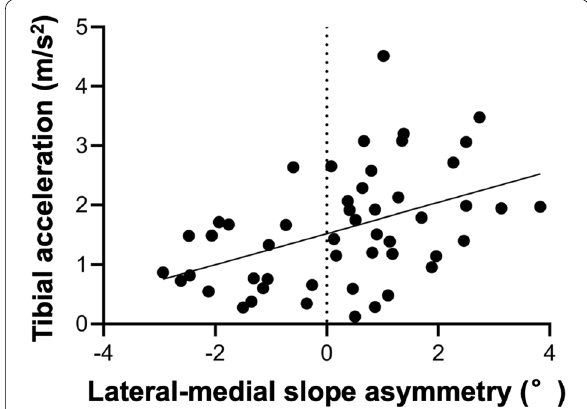
Fig. 4 Correlation between lateral-medial slope asymmetry and tibial acceleration during the pivot-shift test. Tibial acceleration positively correlated with lateral-medial slope asymmetry ( r